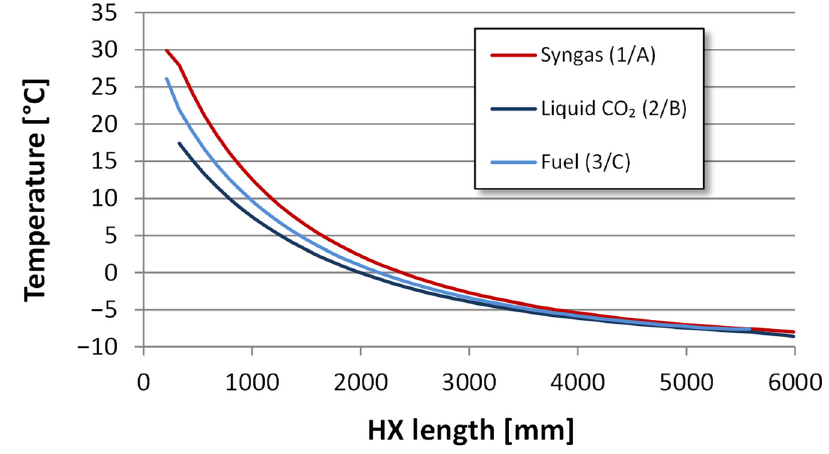
Figure 8. Temperature profiles for plate-fin heat exchanger HX2a.